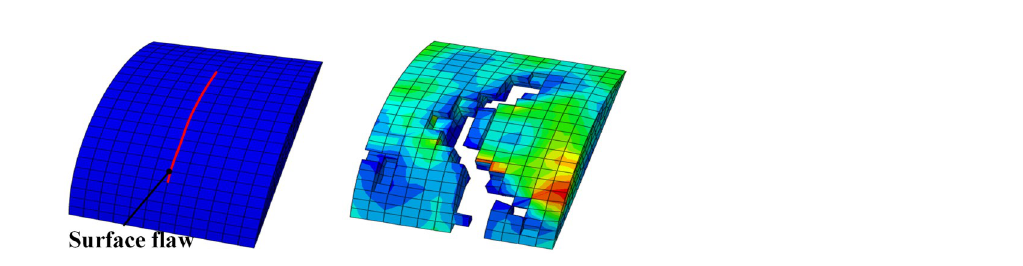
Figure 14. Spring fracture at a surface flaw depth of 55